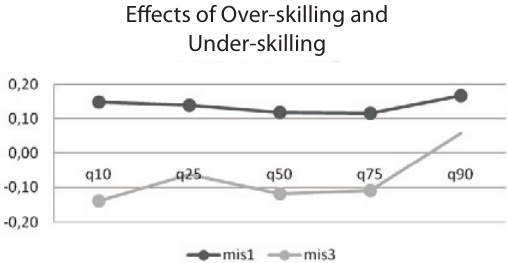
Fig. 2. Figures with the evolution of coefficients for under-skilling (mis1) and over-skilling (mis3) throughout the wage distribution for the pooled regression. Bullets in the graphs indicate statistically significant estimates (10% or higher level of